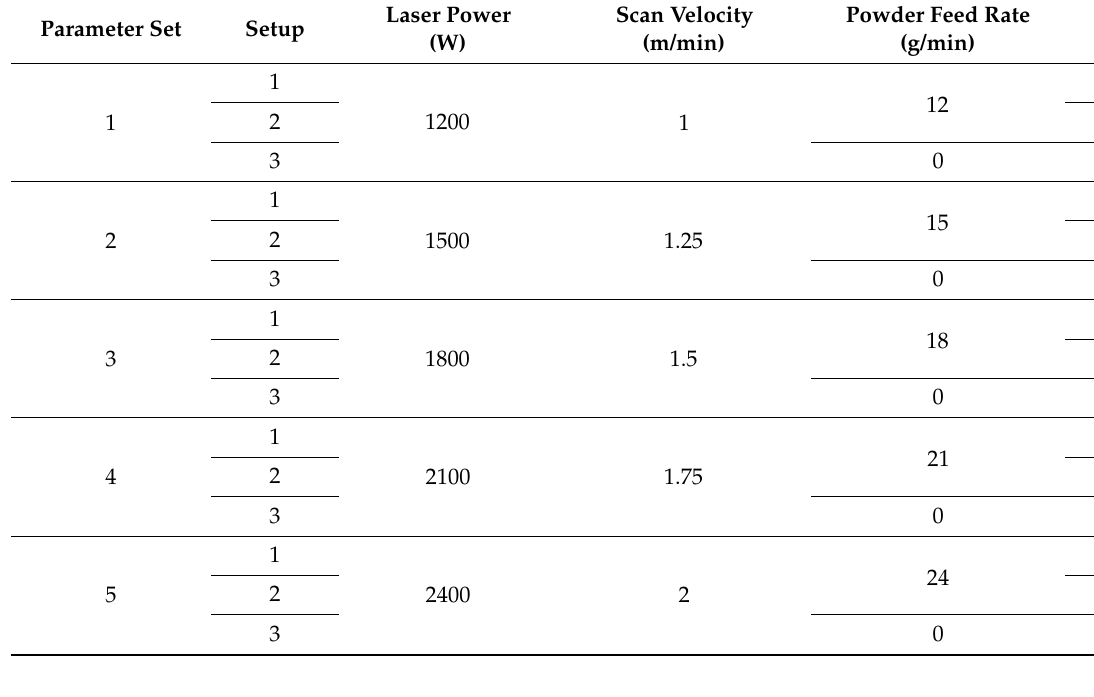
Table 1. Process parameter sets.